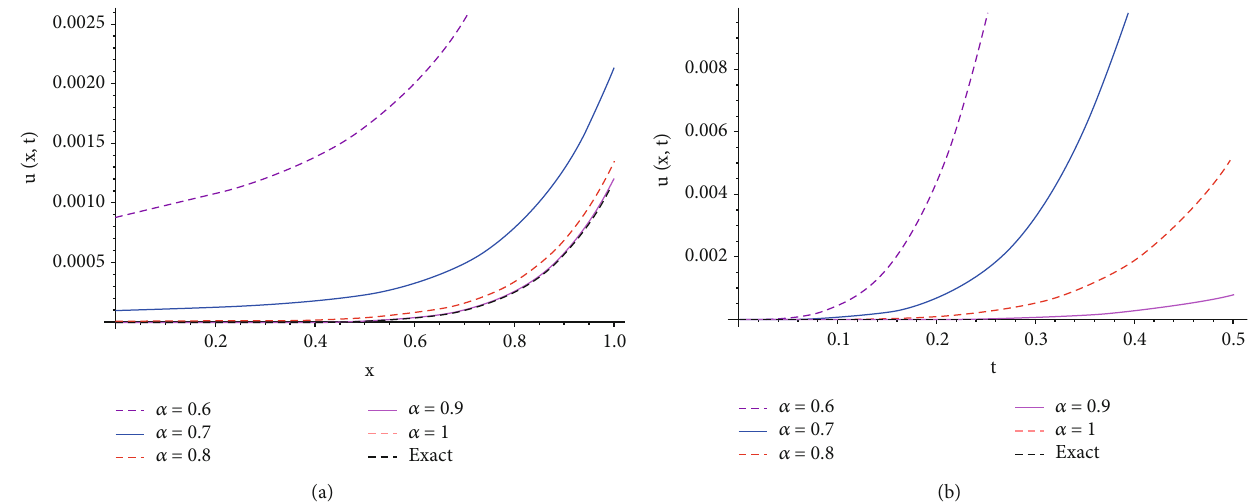
Figure 4: FRDTM solution pro fi le of Eq. (28). (a) u ð x , t Þ vs. x for di ff erent values α and t = 0 : 15 . (b) u ð x , t Þ vs. time t for di ff erent values α and x = 0 : 5 .